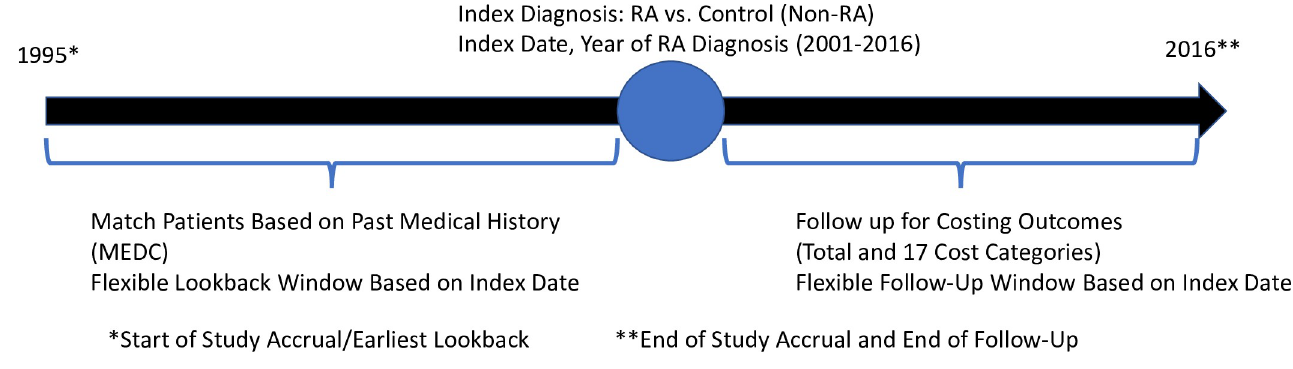
Fig 2. Study diagram of flexible study accrual dates, medical history lookback and outcome follow-up. No legend.